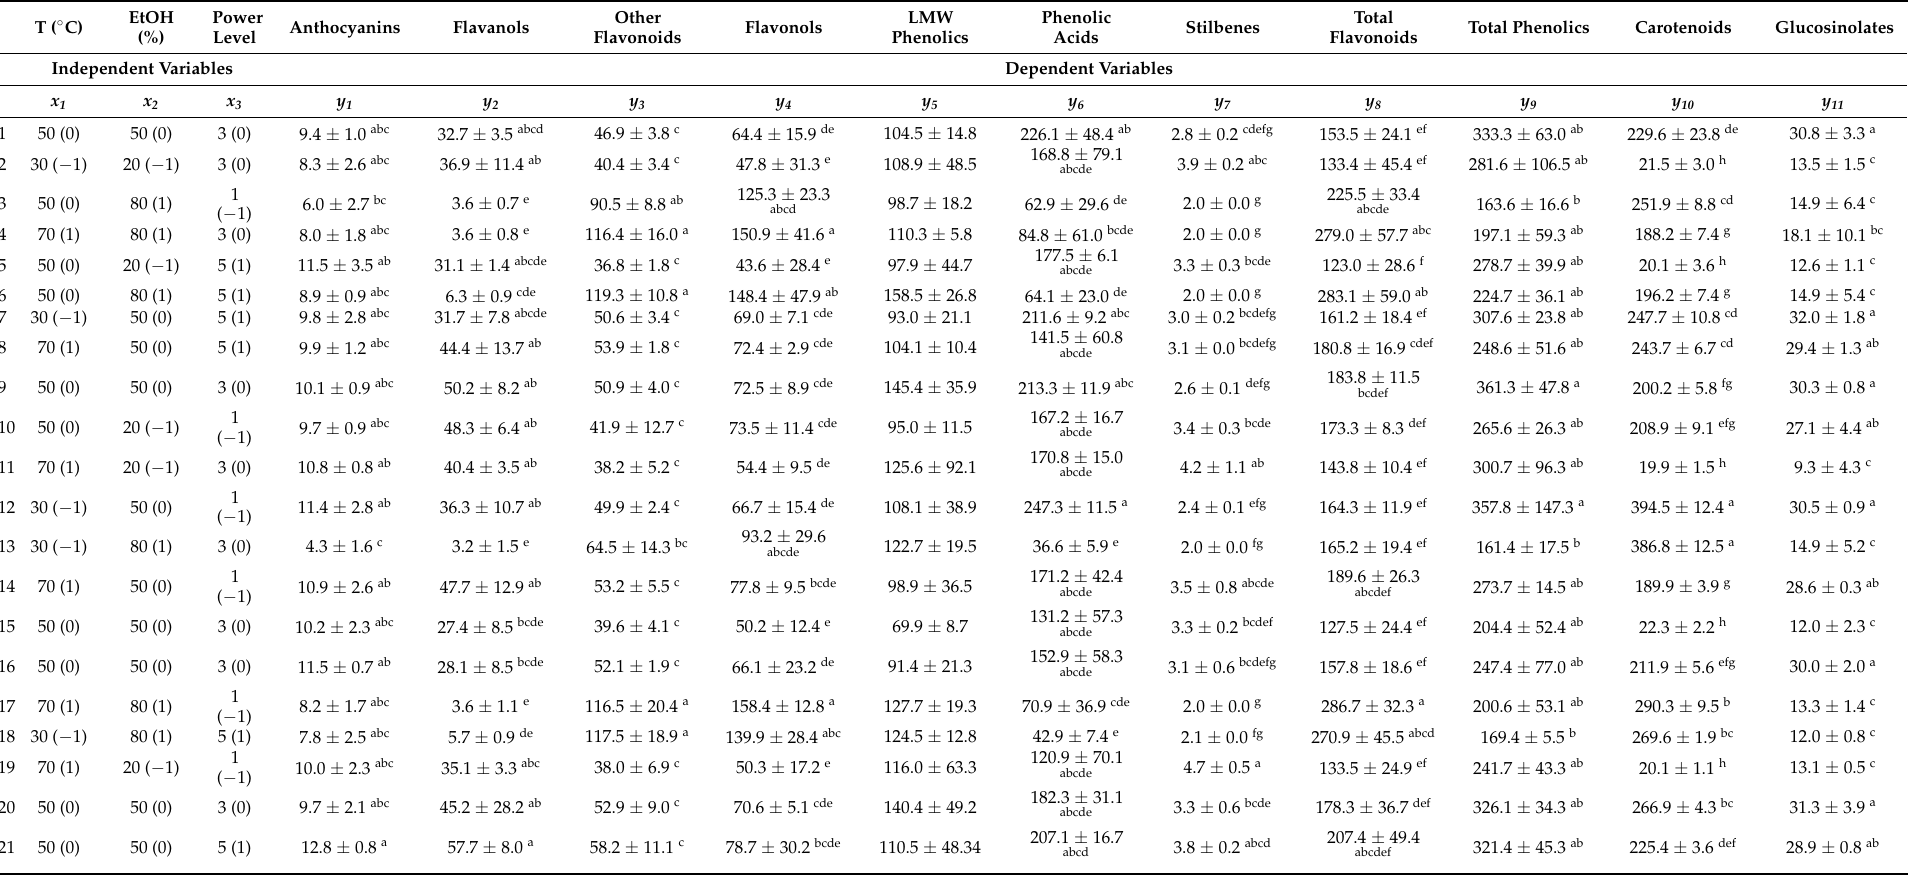
Table 1. Central composite design and experimental results obtained for dependent variables